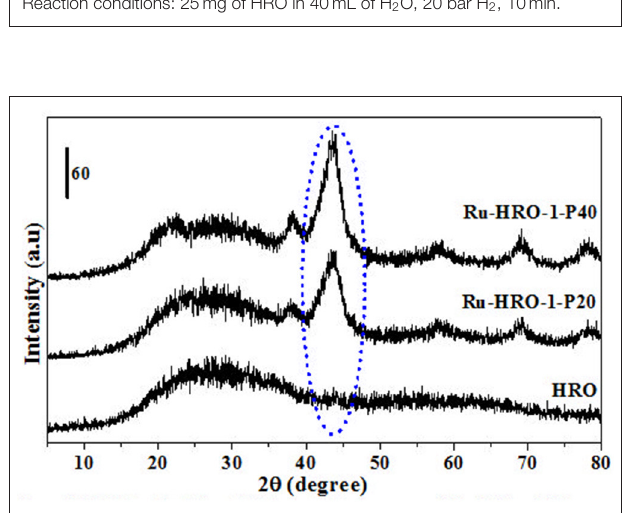
FIGURE 4 | Reduction of HRO to Ru(0) at different H 2 pressure (20–40 bar H 2 ). Reaction conditions: 25mg of HRO in 40mL of H 2 O, 100 ◦ C,